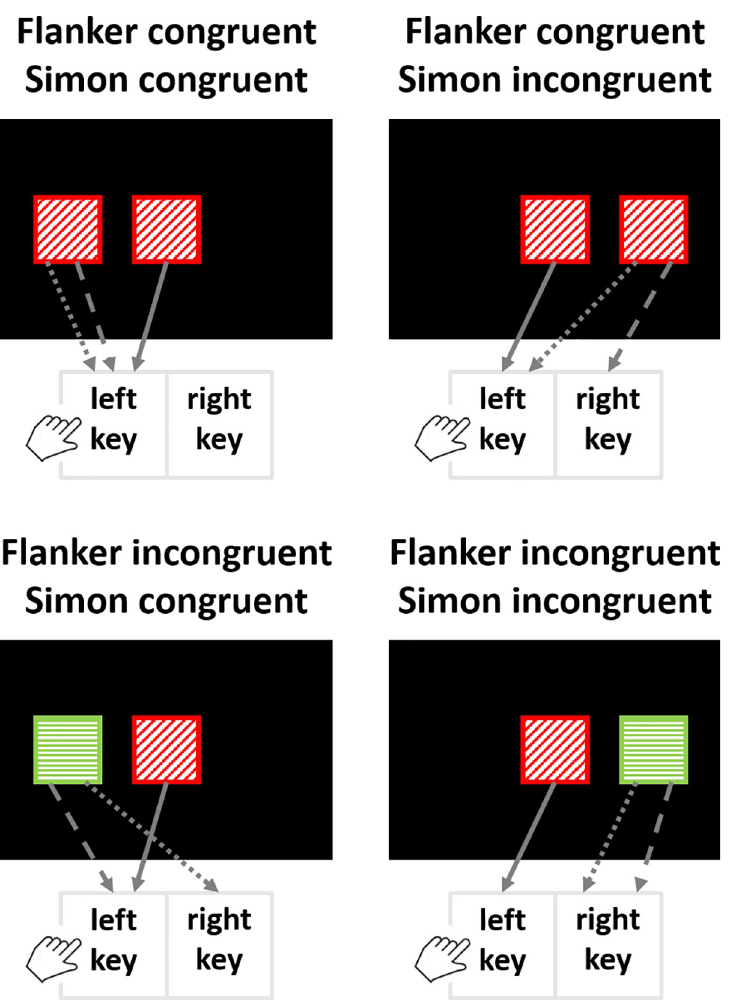
Fig 1. Schematic depiction of the design used by Treccani and colleagues [17] in which both Simon and flanker irrelevant features are conveyed by the same object for all trial types (flanker congruent–Simon congruent, flanker congruent–Simon incongruent, flanker incongruent–Simon congruent, flanker incongruent–Simon incongruent). The target feature associated to the correct response is the color of the central square, which was presented either in red or green. These two colors are additionally presented in oblique and horizontal striations, respectively. The red color was mapped to the left key, whereas the green color was mapped to the right key. Squares presented on the left and right side of the screen were the flanker squares. Solid arrows represent the priming of the target feature (i.e., the color of the central square) to the correct response. Dotted arrows represent the priming of the flanker irrelevant feature (i.e., the color of the flanker square) to the response. Dashed arrows represent the priming of the Simon irrelevant feature (i.e., the left-right location of the screen) to the response. The figure was adapted from the Fig 3 of Treccani and colleagues